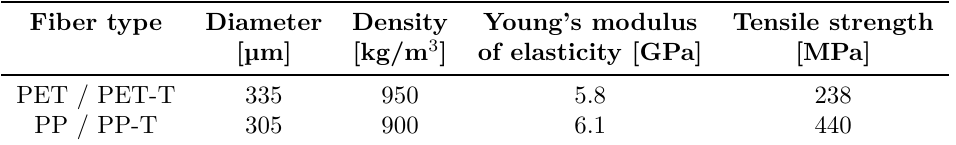
Table 1. Basic geometric and mechanical properties of fibers [12].